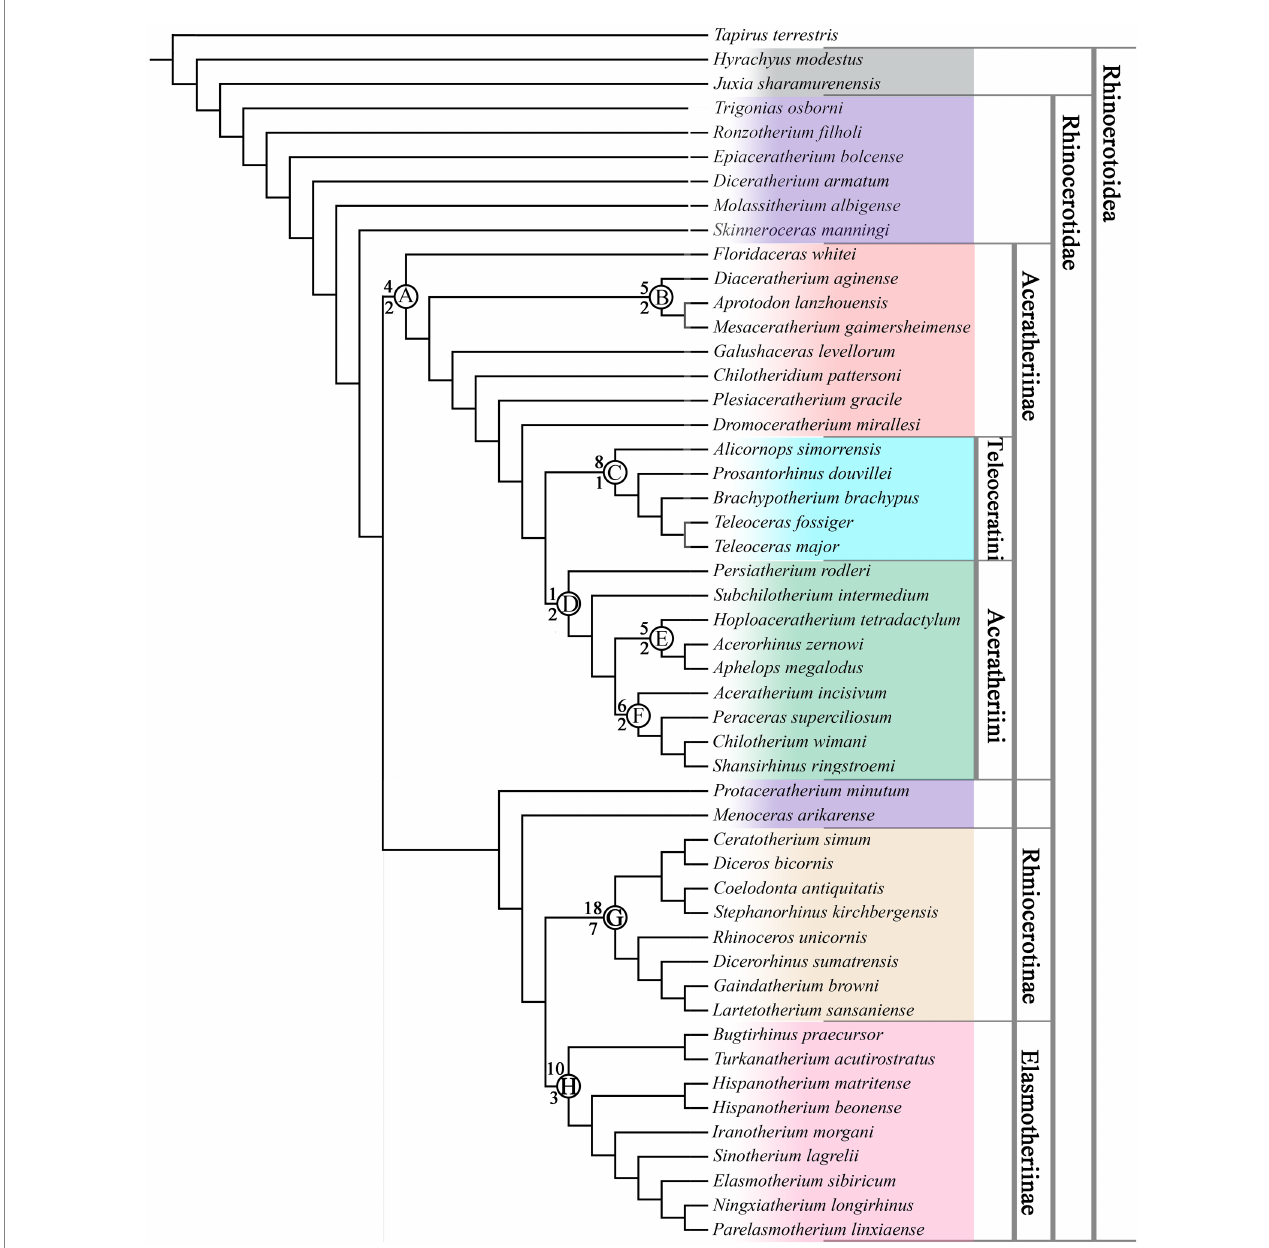
FIGURE 2 Single most parsimonious tree with all characters unordered. Numbers above nodes are counts of synapomorphies and below nodes are Bremer support values. Colored areas and labeled thick lines on the right side indicate phylogeny